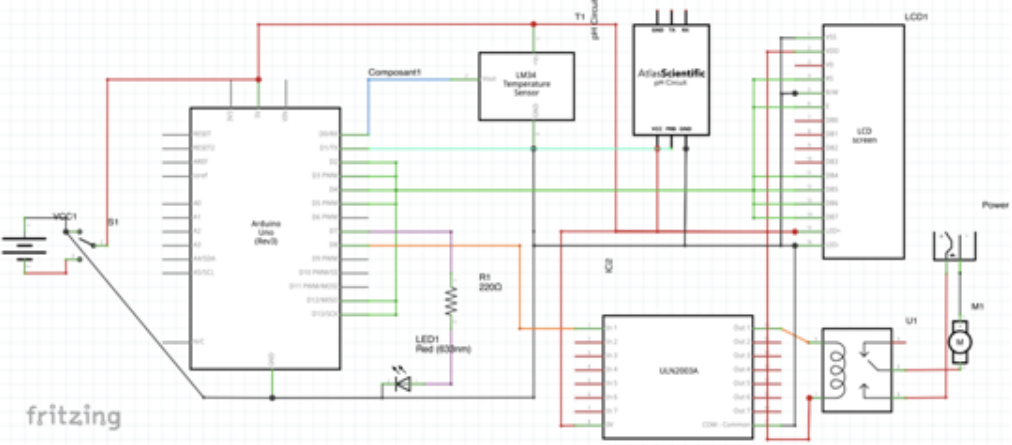
Figure 15. Schematic diagram of the entire electronic